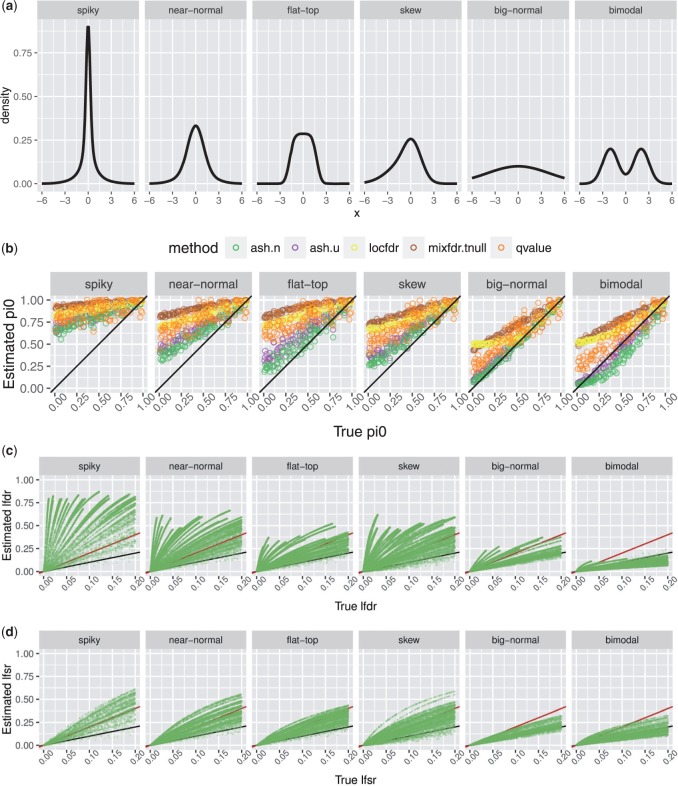
Results of simulation studies (constant precision \documentclass[12pt]{minimal}
\usepackage{amsmath}
\usepackage{wasysym}
\usepackage{amsfonts}
\usepackage{amssymb}
\usepackage{amsbsy}
\usepackage{upgreek}
\usepackage{mathrsfs}
\setlength{\oddsidemargin}{-69pt}
\begin{document}
}{}$s_j=1$\end{document}). (a) Densities of non-zero effects, \documentclass[12pt]{minimal}
\usepackage{amsmath}
\usepackage{wasysym}
\usepackage{amsfonts}
\usepackage{amssymb}
\usepackage{amsbsy}
\usepackage{upgreek}
\usepackage{mathrsfs}
\setlength{\oddsidemargin}{-69pt}
\begin{document}
}{}$g_1$\end{document}, used in simulations. (b) Comparison of true and estimated values of \documentclass[12pt]{minimal}
\usepackage{amsmath}
\usepackage{wasysym}
\usepackage{amsfonts}
\usepackage{amssymb}
\usepackage{amsbsy}
\usepackage{upgreek}
\usepackage{mathrsfs}
\setlength{\oddsidemargin}{-69pt}
\begin{document}
}{}$\pi_0$\end{document}. When the UA holds all methods typically yield conservative (over-)estimates for \documentclass[12pt]{minimal}
\usepackage{amsmath}
\usepackage{wasysym}
\usepackage{amsfonts}
\usepackage{amssymb}
\usepackage{amsbsy}
\usepackage{upgreek}
\usepackage{mathrsfs}
\setlength{\oddsidemargin}{-69pt}
\begin{document}
}{}$\pi_0$\end{document}, with ash being least conservative, and hence most accurate. qvalue is sometimes anti-conservative when \documentclass[12pt]{minimal}
\usepackage{amsmath}
\usepackage{wasysym}
\usepackage{amsfonts}
\usepackage{amssymb}
\usepackage{amsbsy}
\usepackage{upgreek}
\usepackage{mathrsfs}
\setlength{\oddsidemargin}{-69pt}
\begin{document}
}{}$\pi_0 \approx 1$\end{document}. When the UA does not hold (“bimodal” scenario) the ash estimates are slightly anti-conservative. (c) Comparison of true and estimated \documentclass[12pt]{minimal}
\usepackage{amsmath}
\usepackage{wasysym}
\usepackage{amsfonts}
\usepackage{amssymb}
\usepackage{amsbsy}
\usepackage{upgreek}
\usepackage{mathrsfs}
\setlength{\oddsidemargin}{-69pt}
\begin{document}
}{}$\textit{lfdr}$\end{document} from ash (ash.n). Black line is \documentclass[12pt]{minimal}
\usepackage{amsmath}
\usepackage{wasysym}
\usepackage{amsfonts}
\usepackage{amssymb}
\usepackage{amsbsy}
\usepackage{upgreek}
\usepackage{mathrsfs}
\setlength{\oddsidemargin}{-69pt}
\begin{document}
}{}$y=x$\end{document} and red line is \documentclass[12pt]{minimal}
\usepackage{amsmath}
\usepackage{wasysym}
\usepackage{amsfonts}
\usepackage{amssymb}
\usepackage{amsbsy}
\usepackage{upgreek}
\usepackage{mathrsfs}
\setlength{\oddsidemargin}{-69pt}
\begin{document}
}{}$y=2x$\end{document}. Estimates of \documentclass[12pt]{minimal}
\usepackage{amsmath}
\usepackage{wasysym}
\usepackage{amsfonts}
\usepackage{amssymb}
\usepackage{amsbsy}
\usepackage{upgreek}
\usepackage{mathrsfs}
\setlength{\oddsidemargin}{-69pt}
\begin{document}
}{}$\textit{lfdr}$\end{document} are conservative when UA holds, due to conservative estimates of \documentclass[12pt]{minimal}
\usepackage{amsmath}
\usepackage{wasysym}
\usepackage{amsfonts}
\usepackage{amssymb}
\usepackage{amsbsy}
\usepackage{upgreek}
\usepackage{mathrsfs}
\setlength{\oddsidemargin}{-69pt}
\begin{document}
}{}$\pi_0$\end{document}. (d) As in (c), but for \documentclass[12pt]{minimal}
\usepackage{amsmath}
\usepackage{wasysym}
\usepackage{amsfonts}
\usepackage{amssymb}
\usepackage{amsbsy}
\usepackage{upgreek}
\usepackage{mathrsfs}
\setlength{\oddsidemargin}{-69pt}
\begin{document}
}{}$\textit{lfsr}$\end{document} instead of \documentclass[12pt]{minimal}
\usepackage{amsmath}
\usepackage{wasysym}
\usepackage{amsfonts}
\usepackage{amssymb}
\usepackage{amsbsy}
\usepackage{upgreek}
\usepackage{mathrsfs}
\setlength{\oddsidemargin}{-69pt}
\begin{document}
}{}$\textit{lfdr}$\end{document}. Estimates of \documentclass[12pt]{minimal}
\usepackage{amsmath}
\usepackage{wasysym}
\usepackage{amsfonts}
\usepackage{amssymb}
\usepackage{amsbsy}
\usepackage{upgreek}
\usepackage{mathrsfs}
\setlength{\oddsidemargin}{-69pt}
\begin{document}
}{}$\textit{lfsr}$\end{document} are consistently less conservative than \documentclass[12pt]{minimal}
\usepackage{amsmath}
\usepackage{wasysym}
\usepackage{amsfonts}
\usepackage{amssymb}
\usepackage{amsbsy}
\usepackage{upgreek}
\usepackage{mathrsfs}
\setlength{\oddsidemargin}{-69pt}
\begin{document}
}{}$\textit{lfdr}$\end{document} when UA holds, and also less anti-conservative in bimodal scenario.